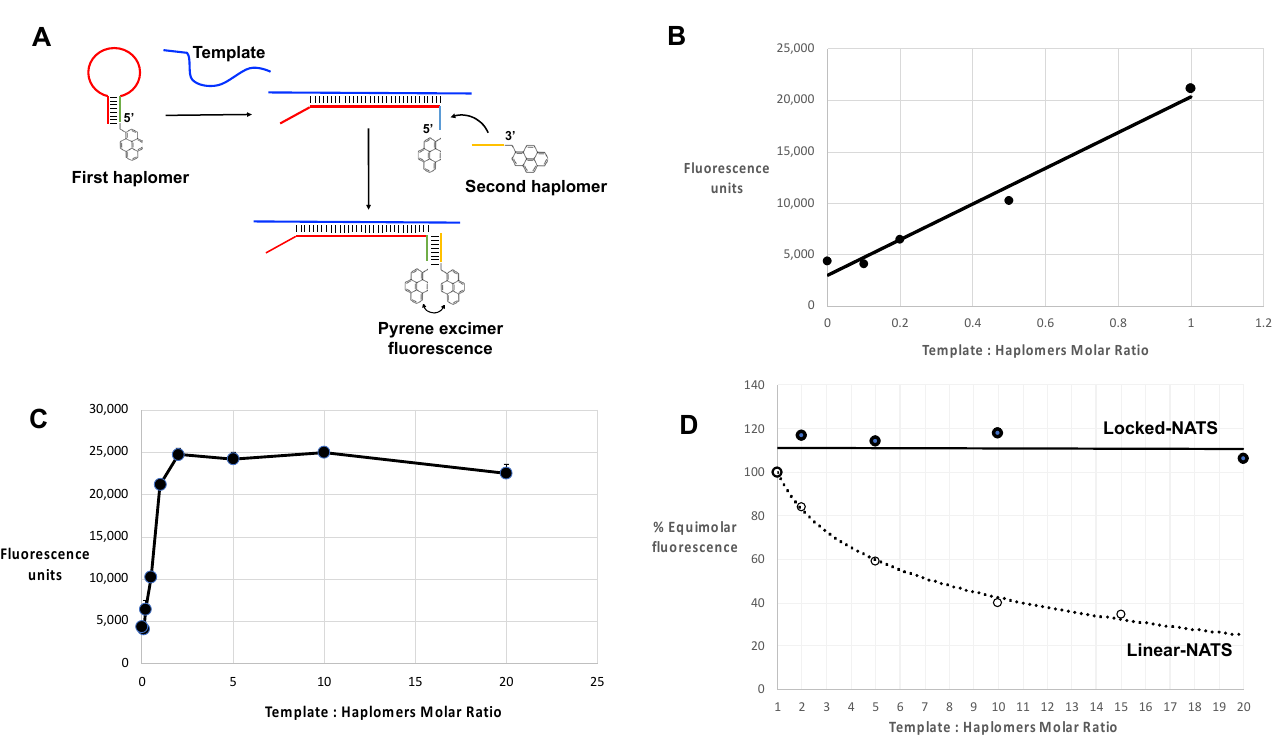
Figure 7. Locked-NATS strategy in conditions of template excess, using pyrene-labeled 2 ′ - O -methyl RNA haplomers in an analogous manner to the linear examples of Figure 3, and as described in Methods, with a 30-mer template GCCACTGTGTCCTGAAGAAAAGCAAAGACA. The First stem–loop pyrene haplomer was Lk-1068M (2 ′ - O -methyl RNA ACUCGAGACGUCUCCUUGUCUUUGCUUUUCUUCAGGACACAGUGGCGAGACGUCUCGAGU), and Second pyrene haplomer